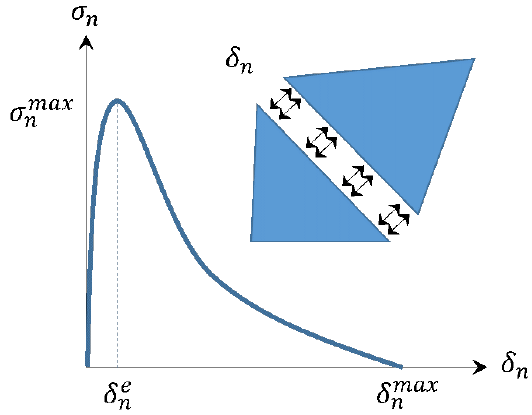
Figure 1. Fracture model : A schematic representation of the fracture model in Hybrid Optimization Software Simulation Suite (HOSS) for Mode I loading. Note that the HOSS simulations have both normal springs and shear springs. But in Figure 1 we have only shown normal springs for convenience.